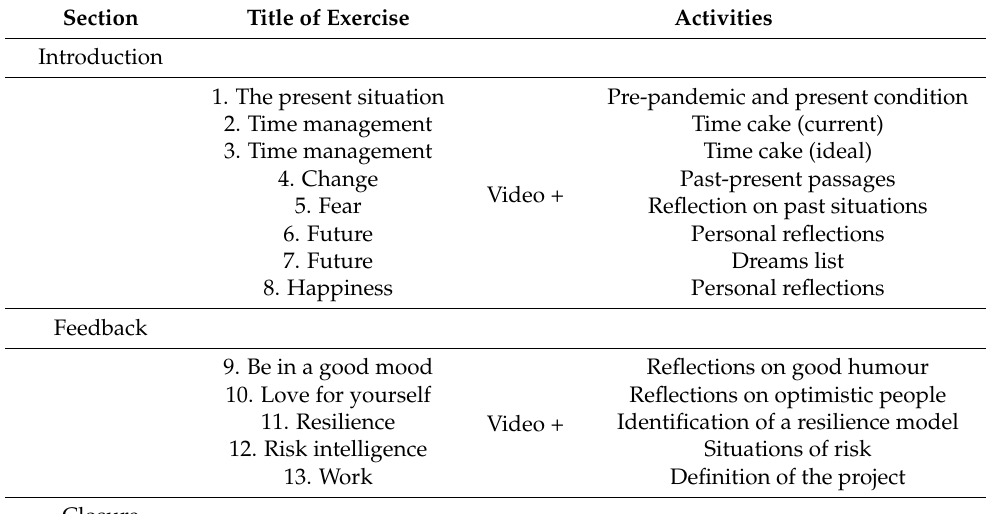
Table 1. Description of the